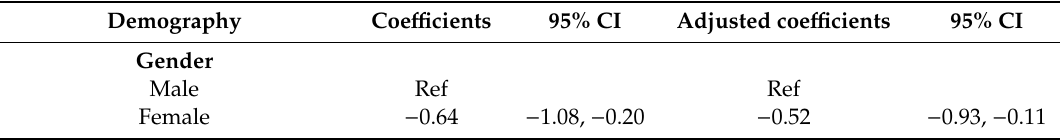
Table A3. Coe ffi cients for factors associated with the perceived risk of COVID-19 among the respondents in Bangladesh during the late lockdown period. Confidence intervals CI including zero are not significant